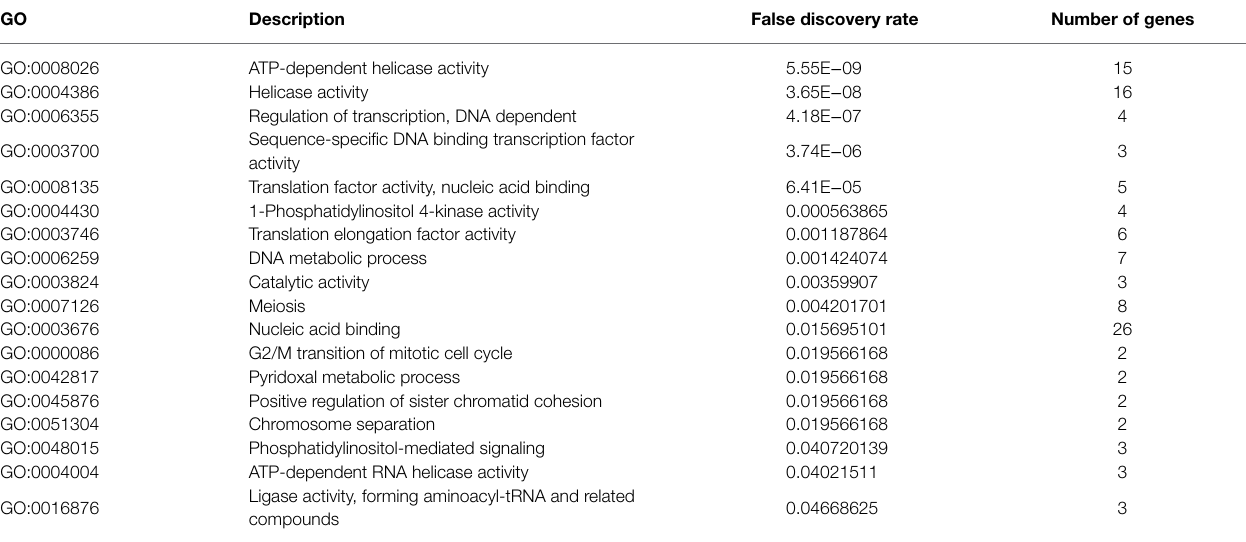
TABLE 6 | Soybean resistance to Phytophthora infection sRNA targeting soybean GO enrichment results. GO